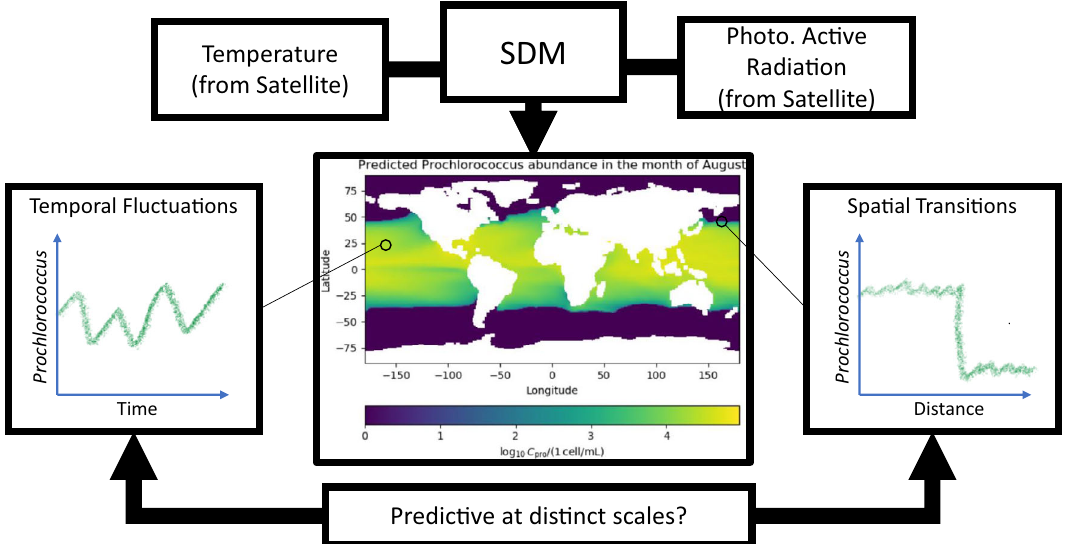
Prochlorococcus cells in the ocean. The schematic shows how this works using satellitedatafortheclimatologicalmonthofAugust.Weexplorethepowerofthese models at distinct spatial-temporal scales by focusing on local temporal fl uctua- tions and sharp spatial transitions in species